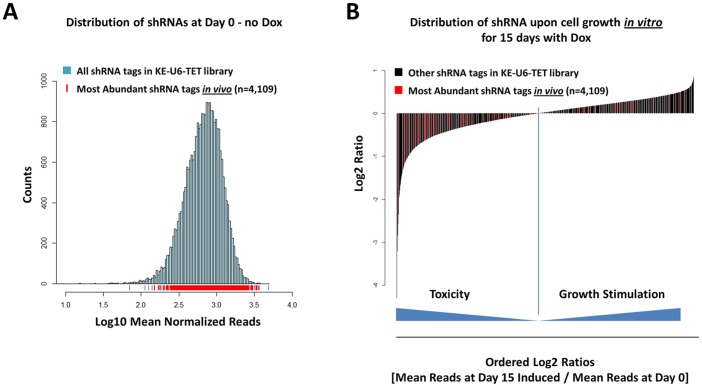
Evidence that encoded shRNA did not influence HCT-116 clonal cell growth in vivo.(A) Distribution of the 4,109 unique barcodes retrieved most abundantly from the three xenograft tumors (marked with red vertical lines) across the entire shRNA population distribution in the shRNA library. (B) Detection of a large fraction of the most abundant barcodes from the three xenograft tumors (marked in red) in the shRNA population most toxic to HCT-116 upon Doxycycline induction in vitro for 15 days (measured by a negative Log2 ratio of mean read counts for individual shRNA at Day 15 following Doxycycline to mean read counts at Day 0).